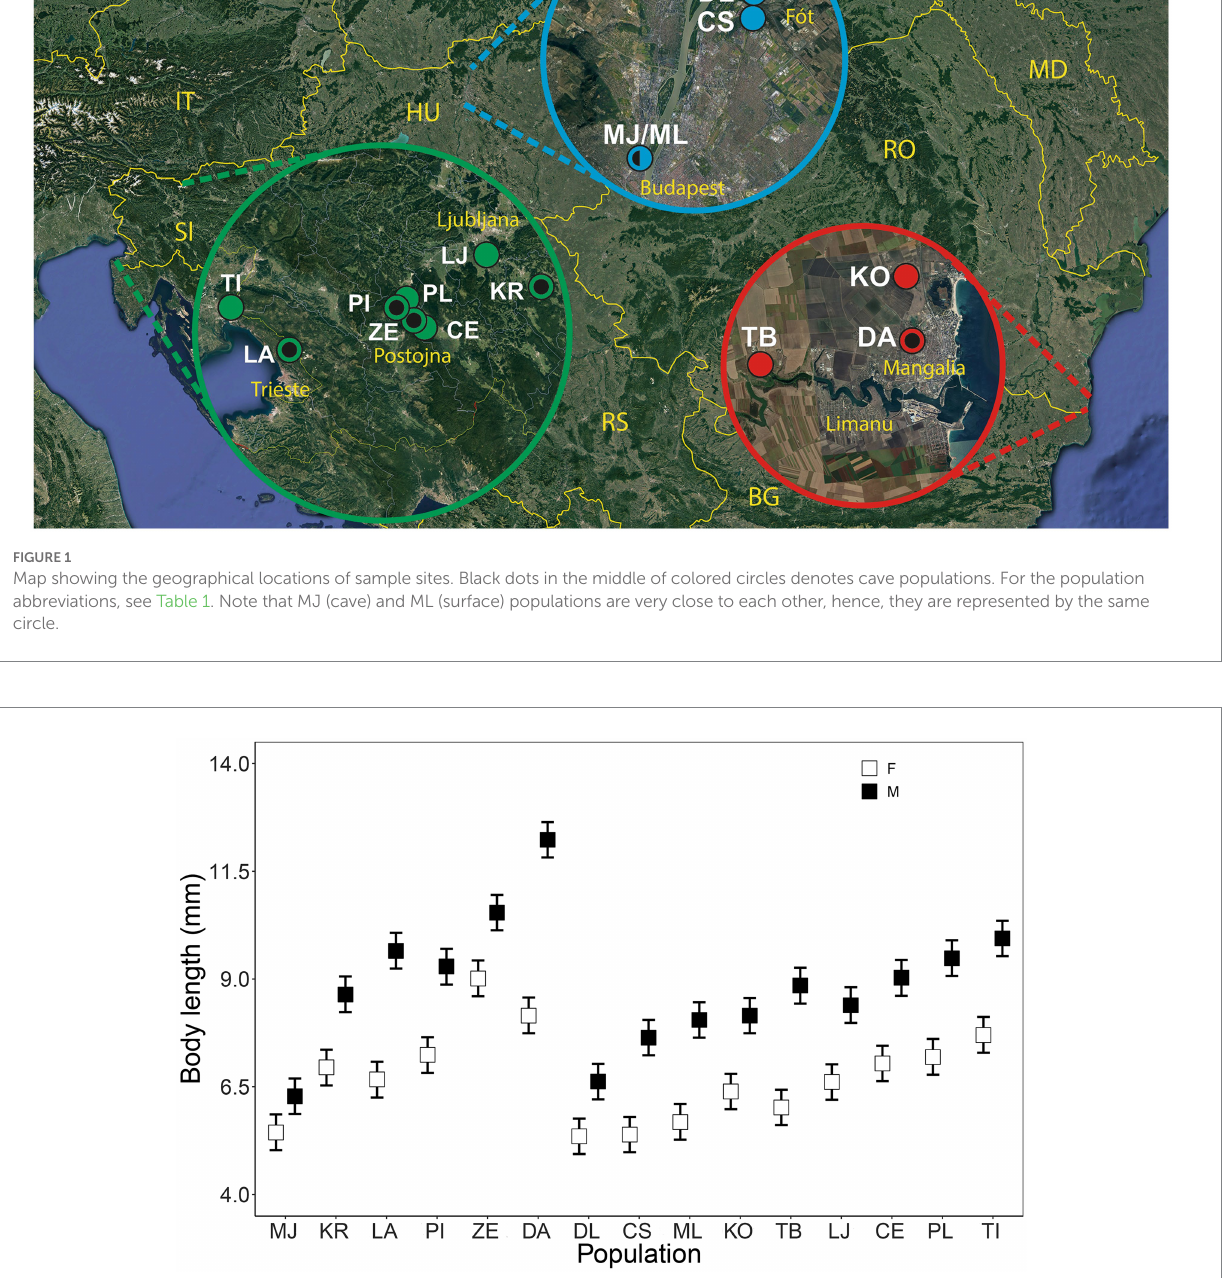
FIGURE 2 Body length variation of female (F) and male (M) Asellus aquaticus from the cave (MJ, KR, LA, PI, ZE, DA) and surface (DL, CS, ML, KO, TB, LJ, CE, PL, TI) populations. Estimated marginal means and 95% confidence intervals are shown. The population codes are explained in Table